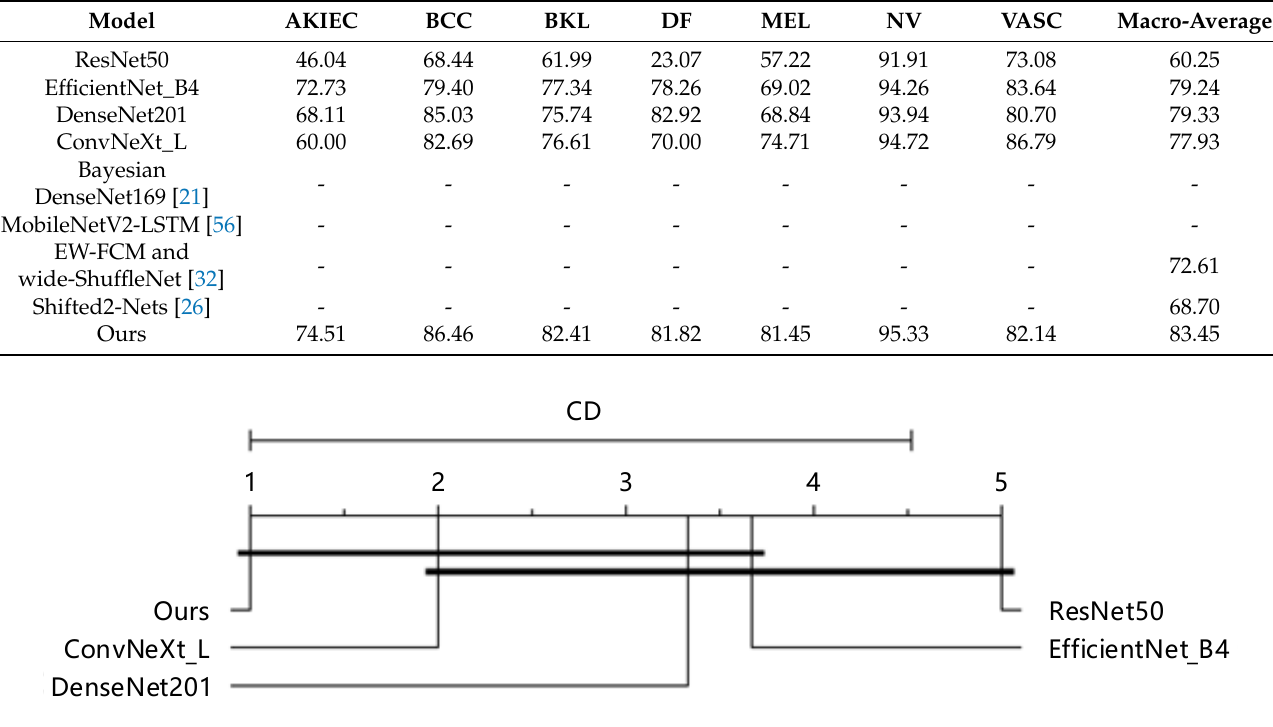
Figure 9. The critical difference diagram.